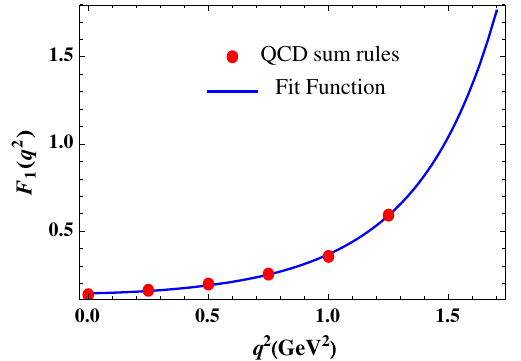
Fig. 3 The sum rule predictions for the weak form factor G 1 ( q 2 ) and the fit function F 1 ( q 2